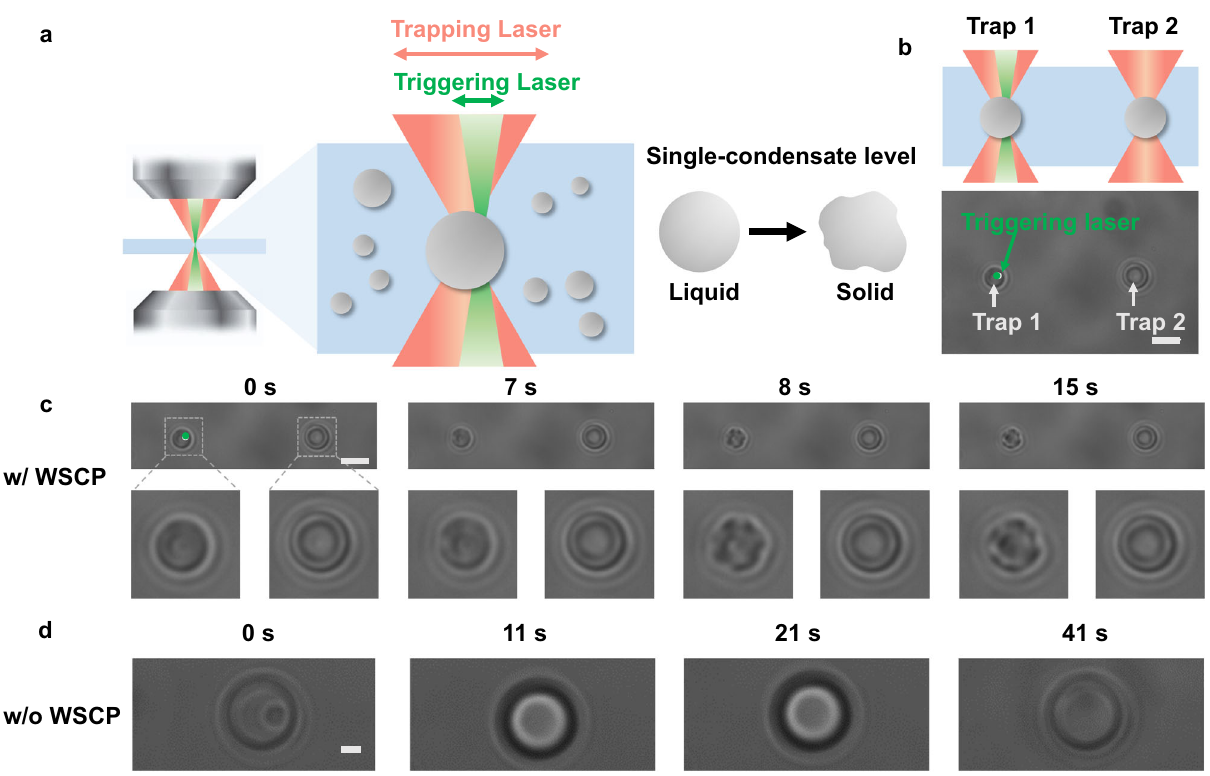
Fig. 5 Modulation of RMR/WSCP condensates with high spatial precision by optical tweezers. a Schematic illustration of the use of a modi fi ed optical tweezer system consisting of trapping and triggering laser beams to modulate the protein condensates at the single-condensate level. Trapping laser: 1064 nm; 80 mW. Triggering laser: 532 nm; 2.5 mW. b Schematic illustration of the trapping of two protein condensates (Trap 1 and Trap 2) by optical tweezers, followed by selective irradiation of the chosen condensate (Trap 1; left) via the triggering laser beam. A live camera image of two trapped condensates is shown. Scale bar: 5 μ m. c Liquid-to-solid phase transition of the chosen RMR/WSCP condensate ( left ) under the irradiation of the triggering laser beam within 15 s. The concentration of WSCP is 5 μ M. Scale bar: 5 μ m. Images representative of n = 9. d The RMR condensate in the absence of WSCP is inert to prolonged irradiation. Scale bar: 1 μ m. Images representative of n =